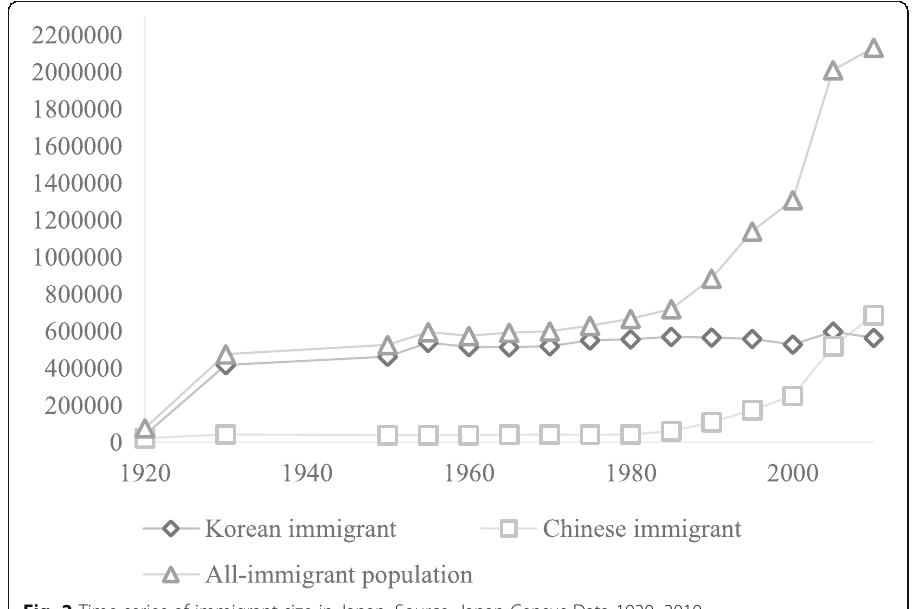
Fig. 2 Time series of immigrant size in Japan. Source: Japan Census Data 1920 – 2010